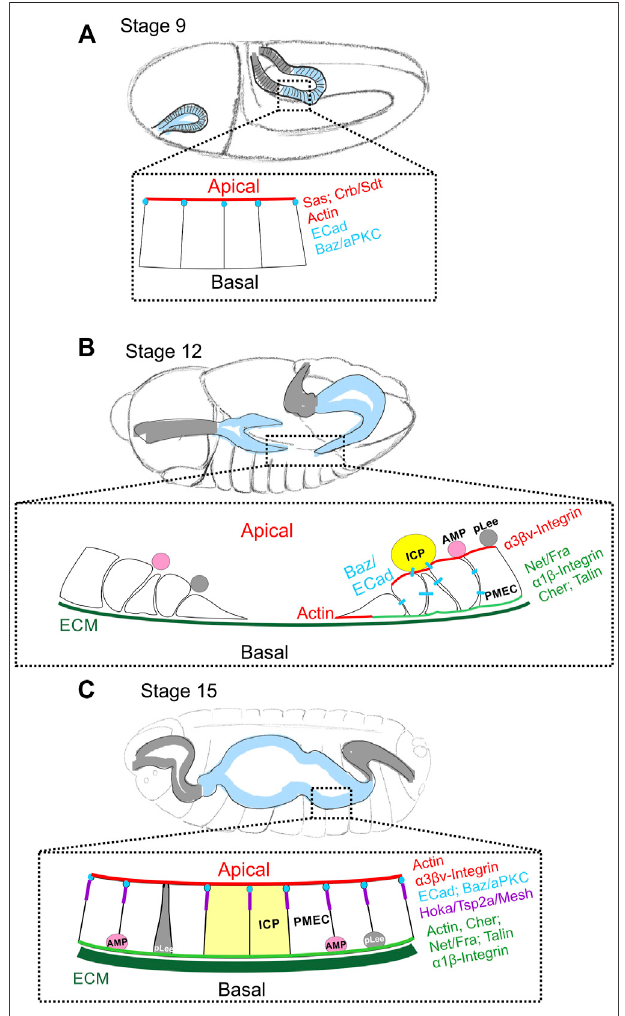
FIGURE 2 | Changes in cell polarity during embryonic midgut formation. (A) During gastrulation at stage 9, the endoderm (blue shaded region) and ectodermofthehindgut(grayshadedregion)invaginate.Theposteriormidgut (all esg +) is still an epithelium with Sas and Crb/Sdt at the apical domain (red) and Ecad and Baz/aPKC at the apical AJs (blue). At this stage, the visceral muscle layer is not yet fully formed, and no clear basal features have beendescribed. (B) Bystage12,Crb/SdtandSashavedisappearedfromthe midgut primordia and the cells have undergone EMT and become migratory. The presumptive posterior and anterior midgut rudiments migrate along the visceral mesoderm towards each other. ECM (dark green) components can befoundbetweentheendodermandvisceralmesodermbylatestage12.The posterior midgut primordium segregates into principal midgut epithelial cells (PMECs),Interstitialcellprecursors(ICPs; yellow)andadultmidgut precursors (AMPs; pink), while the anterior primordium contains only PMECs and AMPs. ICPs to delaminate fi rst, followed by the AMPs and both remain attached to the migrating PMECs. At stage 11, the inner layer of migrating mesenchyme also contains esg + Pros + cells, possibly the progenitors of the larval ee cells (pLees; gray). Both theAMPsand pLees remain attached to PMECs until later stages. Actin is enriched at the basal, migratory front and Baz (blue) can be found at spot AJs between PMECs and ICPs. Behind the migrating front, PMEC cells start to repolarise. Talin and Filamin1/Cher are localised basally (green) together with Fra and the α 1/ β -integrin complex, while the α 3 βν - integrin complex localises apically (red). (C) By stage 15, the anterior and posterior midgut primordia have fused and the presumptive midgut has